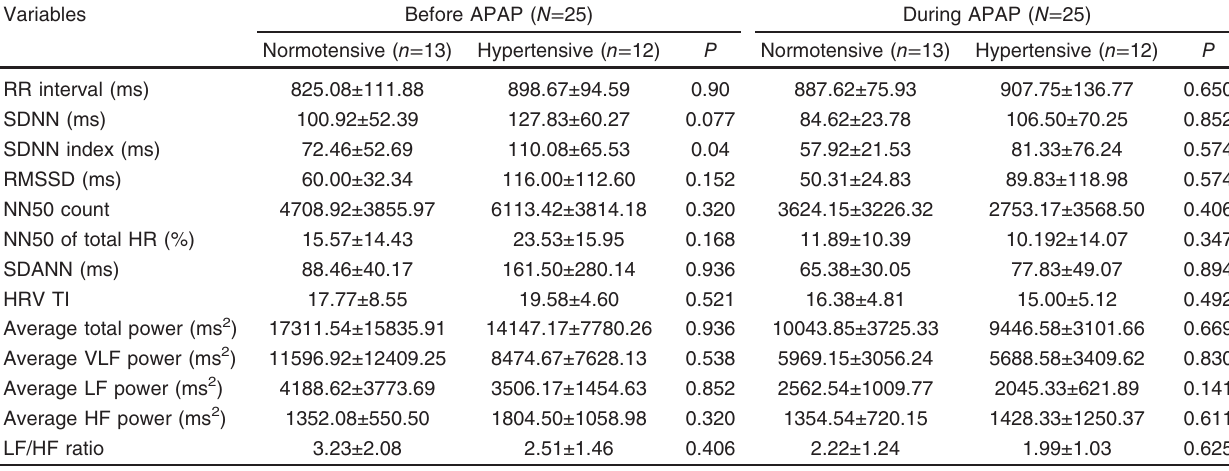
Table 3 Heart rate variability in normotensive versus hypertensive obstructive sleep apnea syndrome patients before and during automatic positive airway pressure